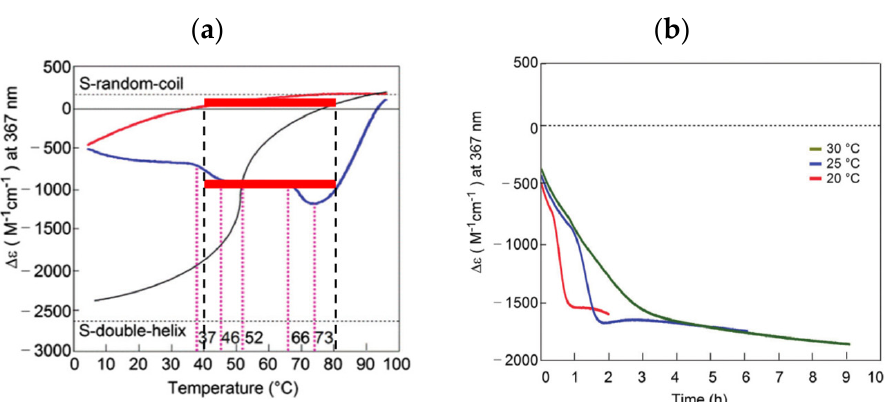
Figure 13. ( a ) Thermal hysteresis of ( M ) –2 in toluene (0.1 mM) between 95 and 5 °C at a rate of 1.0 K min –1 . Black line shows equilibrium curve, and red bold lines indicate bistability involving metastable states. ( b ) Distorted sigmoidal kinetics under isothermal conditions. Reproduced from ref. [61].